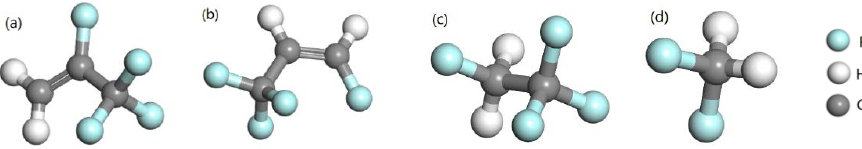
Figure 2. Atomic configurations of R1234yf ( a ); R1234ze ( b ); R134a ( c ) and R32 ( d ). Materials 2018 , 11 , x FOR PEER REVIEW